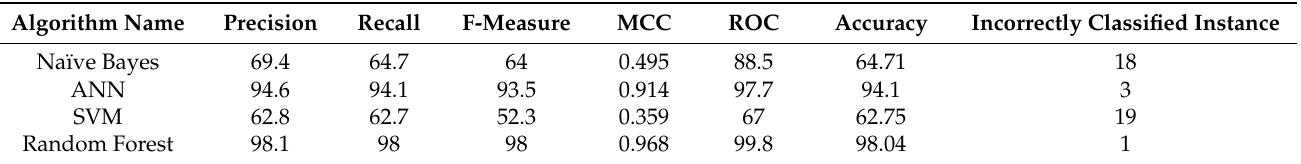
Table 5. Comparison among classification algorithms during the training phase to predict the total critical cases.